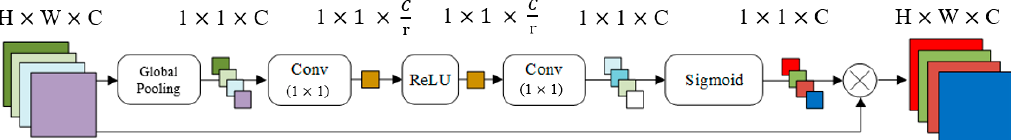
Figure 4. Schematic diagram of channel attention mechanism.